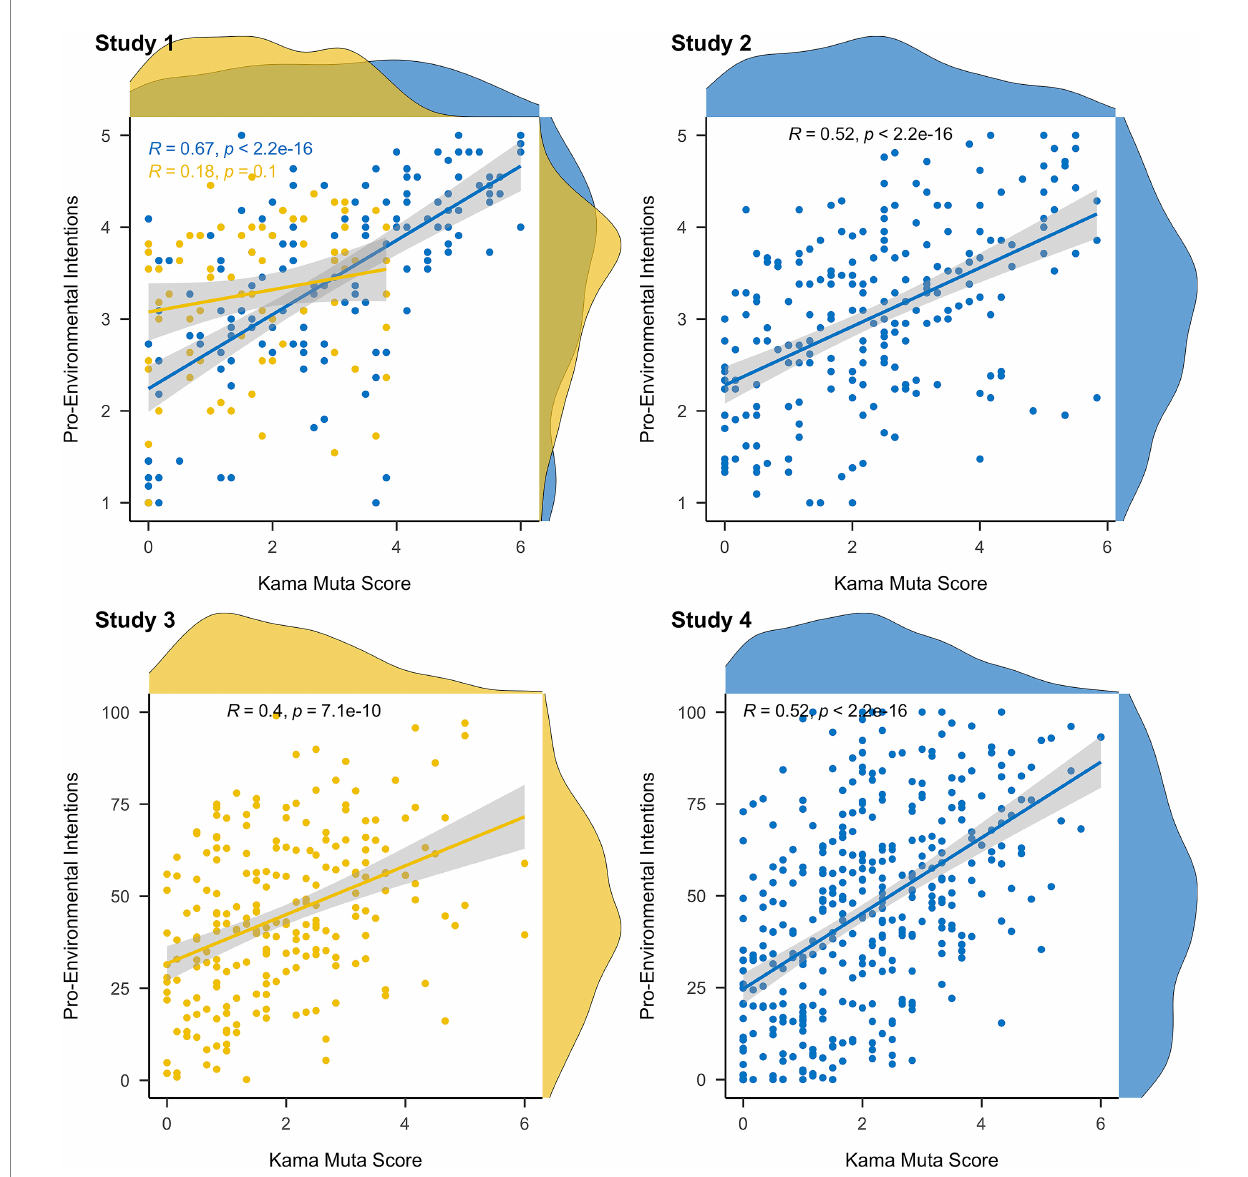
FIGURE 1 Overview of the relationship between kama muta and pro-environmental intentions across the four studies. Gray shaded area indicates 95% confidence intervals. Blue represents the US and yellow is